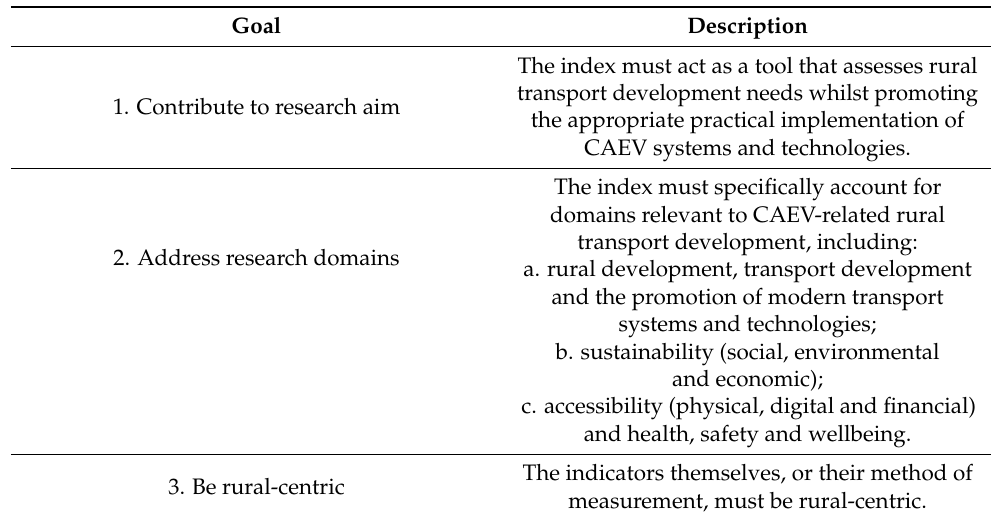
Table 2. CARTI goals and